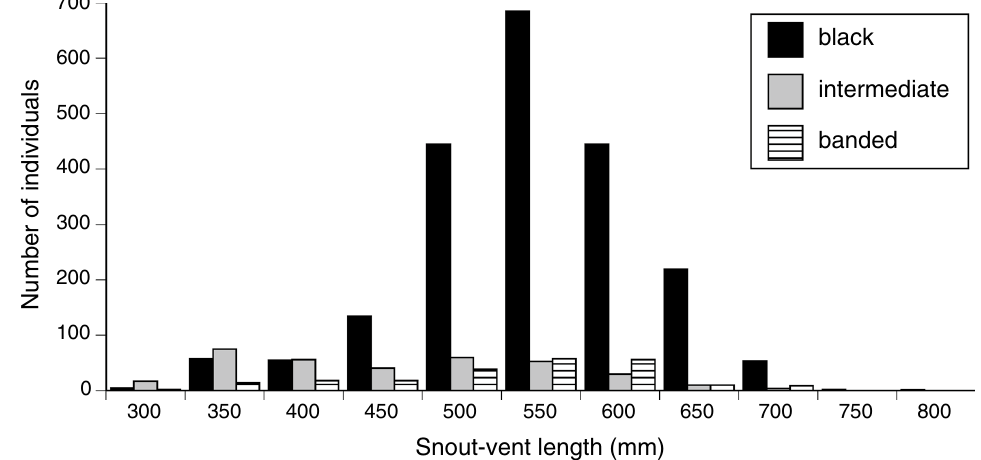
Figure 2. Frequency distributions of body lengths (snout-vent lengths) for each colour morph in turtle-headed sea snakes, Emydocephalus annulatus .